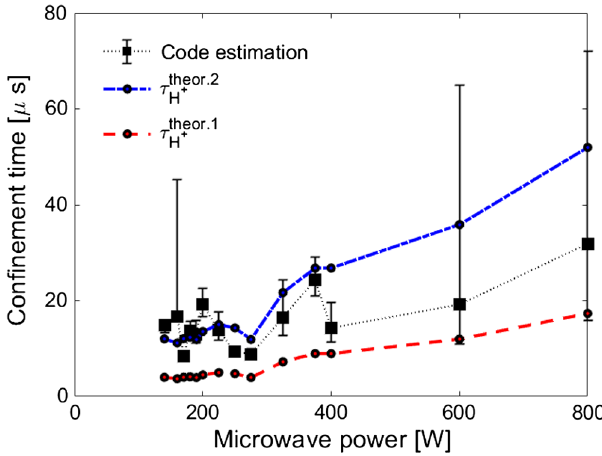
estimated by the semi- H þ < ¯ τ < H þ H þ